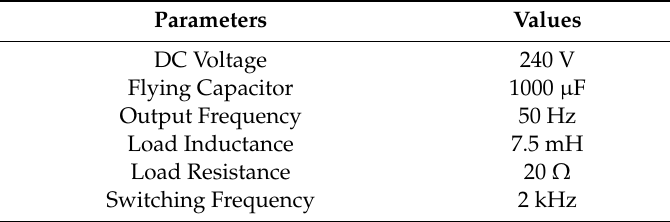
Table 5. Experimental parameters of the four-level converter.